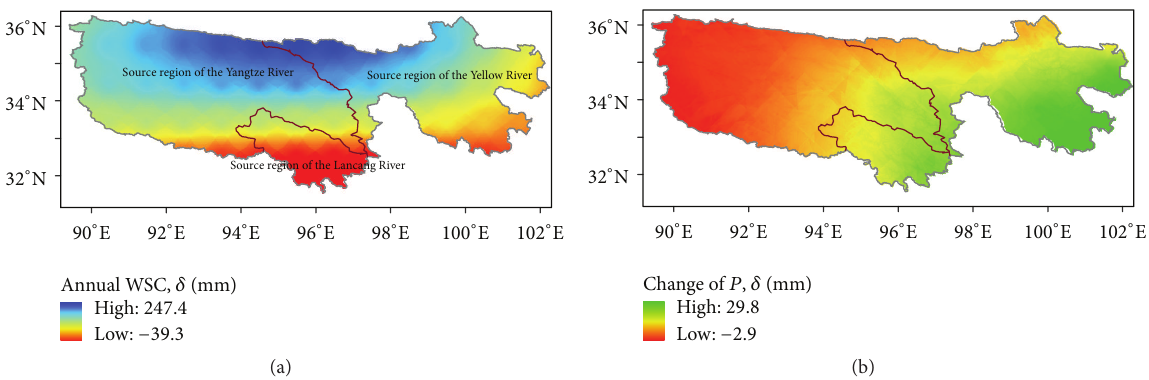
Figure 2: Spatiotemporal patterns of average annual (a) water storage change (WSC) and (b) precipitation ( 𝑃 ) over the Three-River Source Region during 2003–2010.